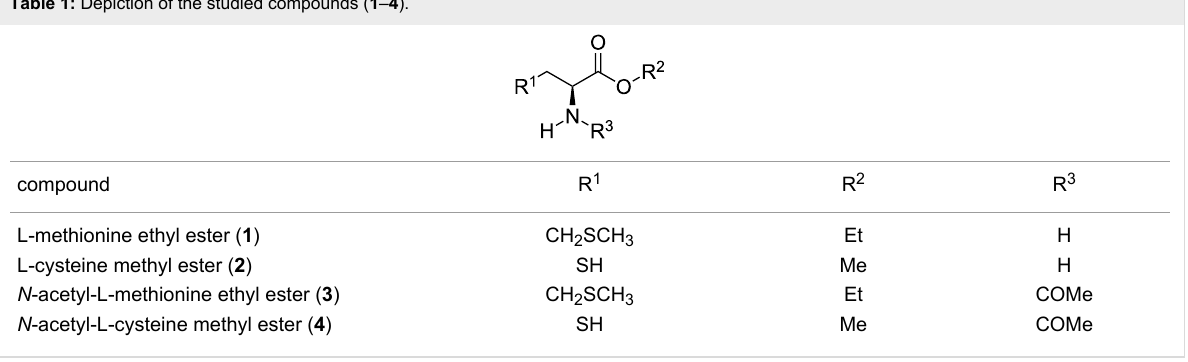
Table 1: Depiction of the studied compounds ( 1 – 4